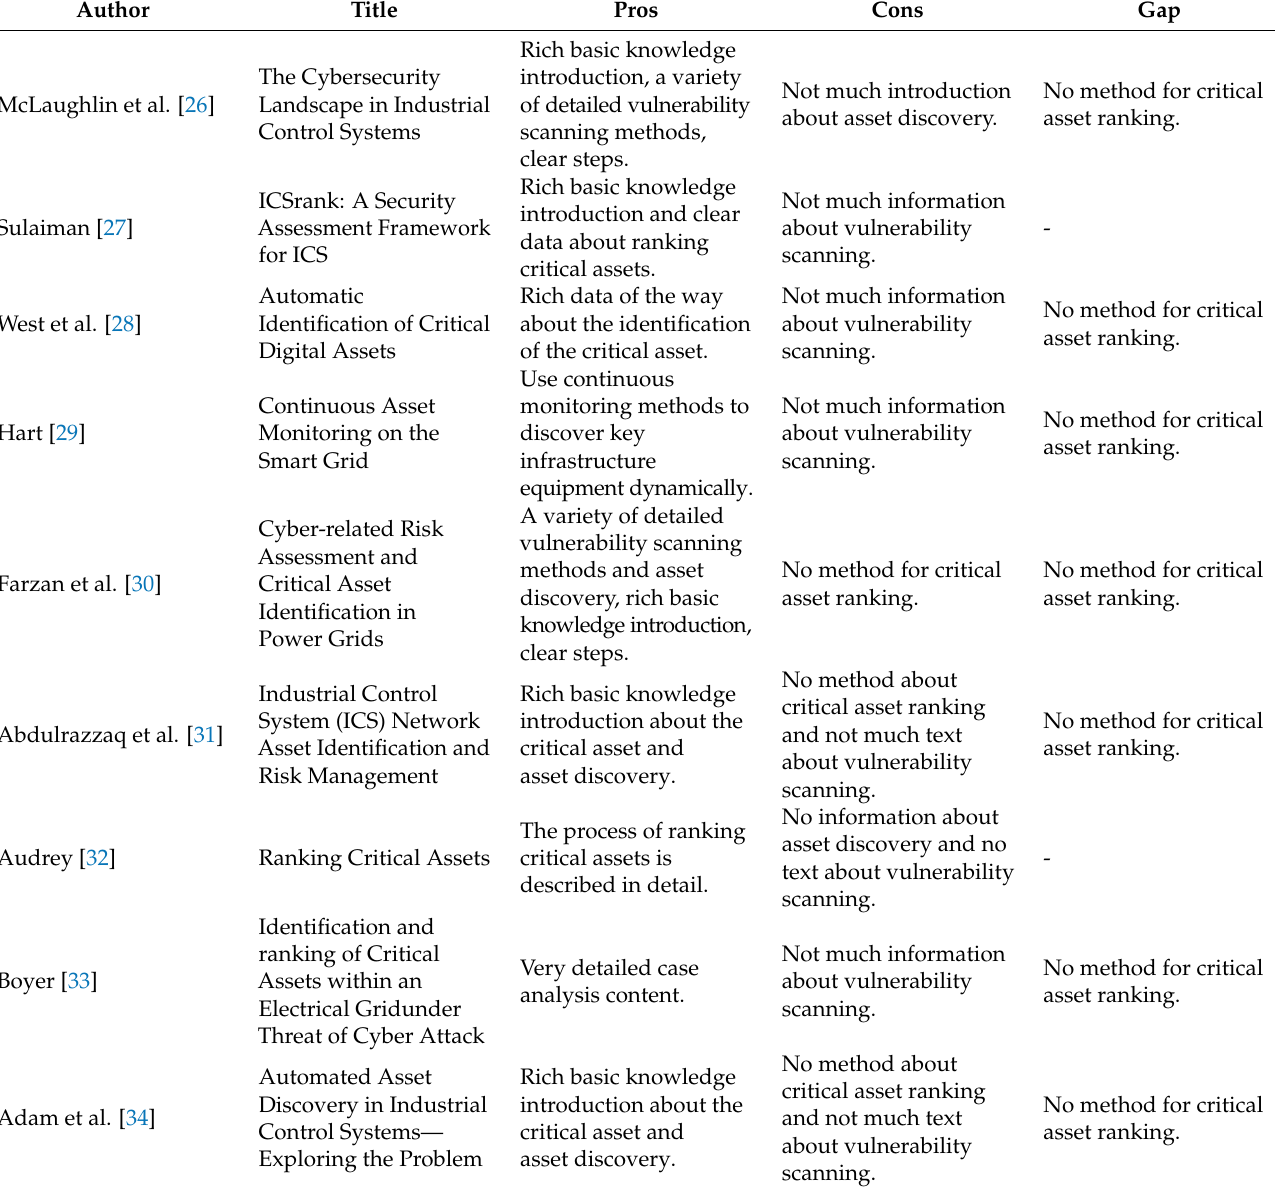
Table 3. Existing Solutions for Asset Discovery in